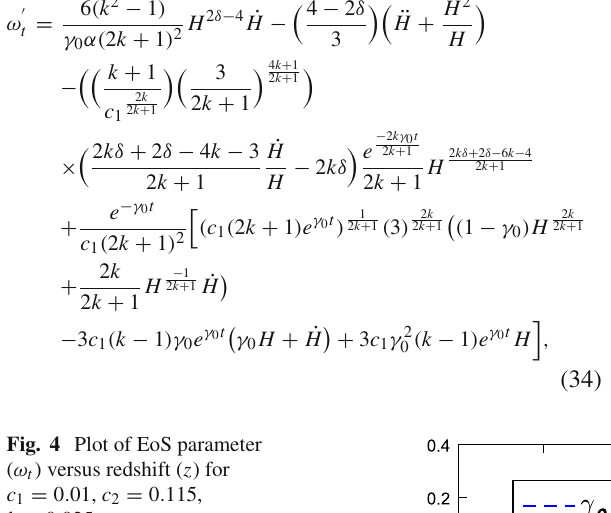
Fig. 4 Plot of EoS parameter ( ω t ) versus redshift ( z ) for c 1 = 0 . 01, c 2 = 0 .